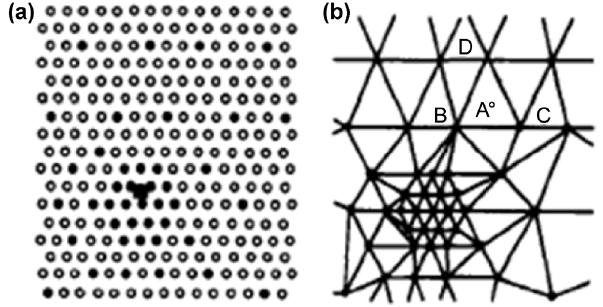
Fig. 1 Schematic of QC method.